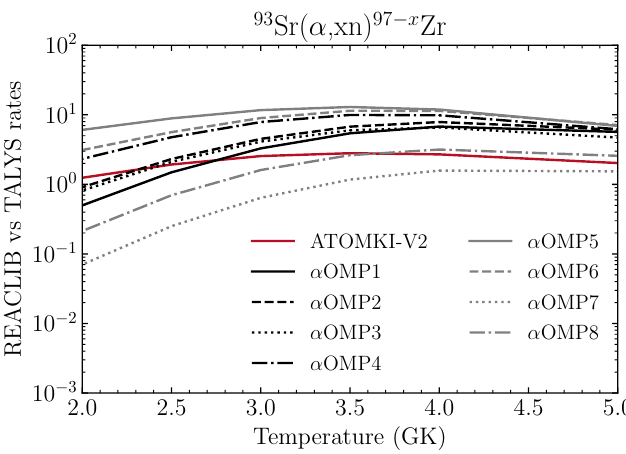
Figure 1. Comparison of the REACLIB 93 Sr( α, xn ) 97 − x Zr reaction rate to the TALYSv1.95 predictions using the 8 di ff erent α Optical Model potentials ( α OMP) available in the code, including the Atomki– V2 potential [10] for the astrophysical window of the weak r